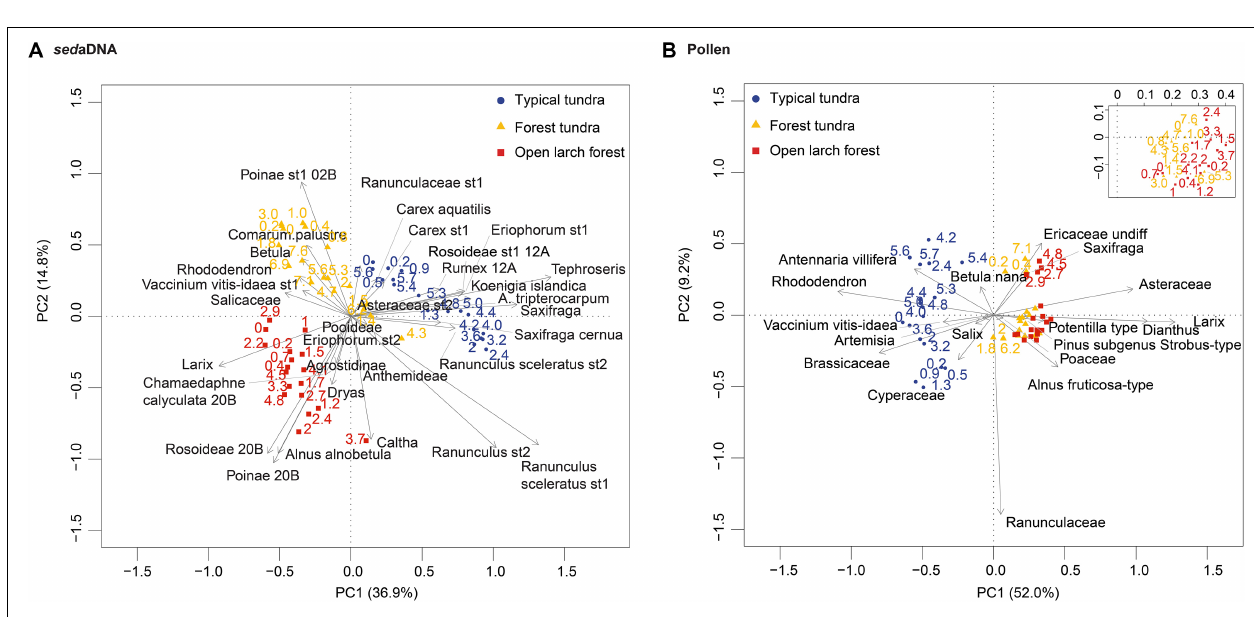
FIGURE 6 | Percentages of selected taxa/sequences over the past 4.8 ka from the open larch forest site (14OM20B) in the Omoloy region used in our statistical analyses, shown as red bar plots of relative read abundance of seda DNA and blue bar plots of pollen percentages. The families detected by both of sedaDNA and pollen analyses are marked as black lines. CONISS zones for each proxy are shown on the right.